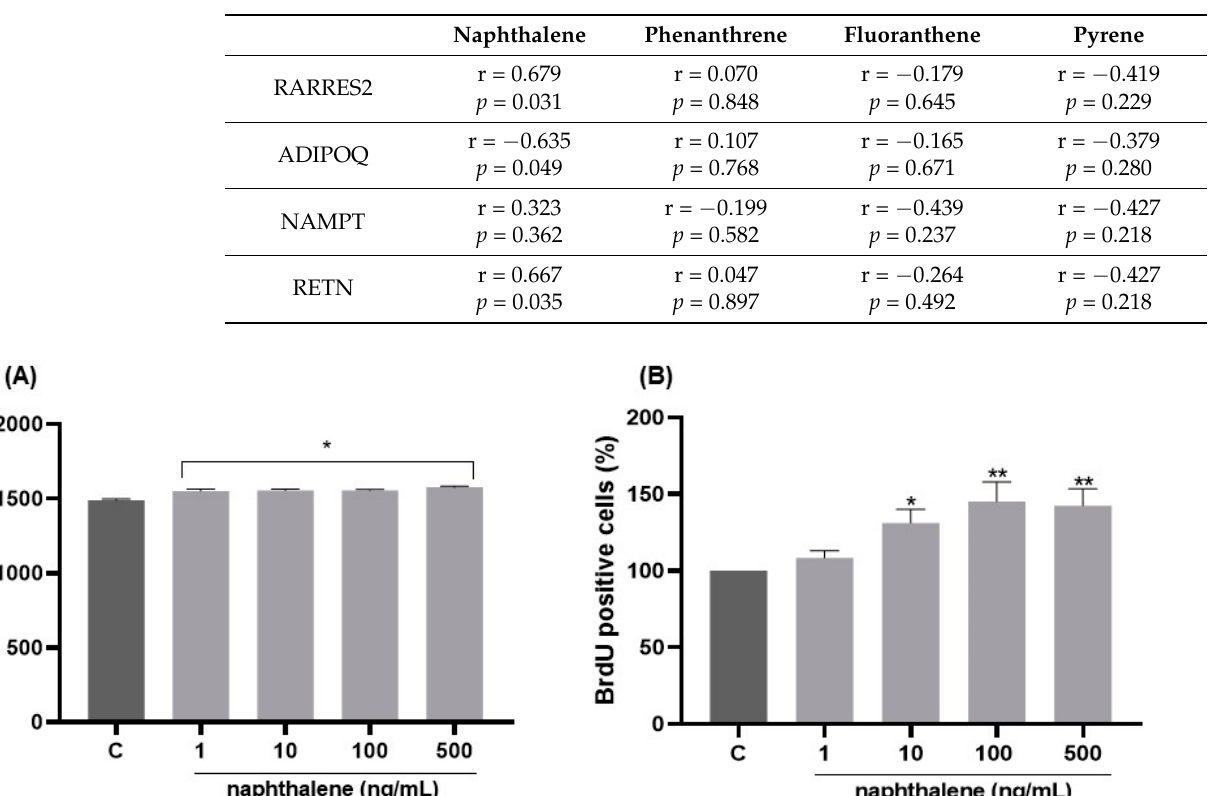
Table 6. Correlation between PAH concentration and adipokines mRNA level in omental AT of French patients ( n = 10).